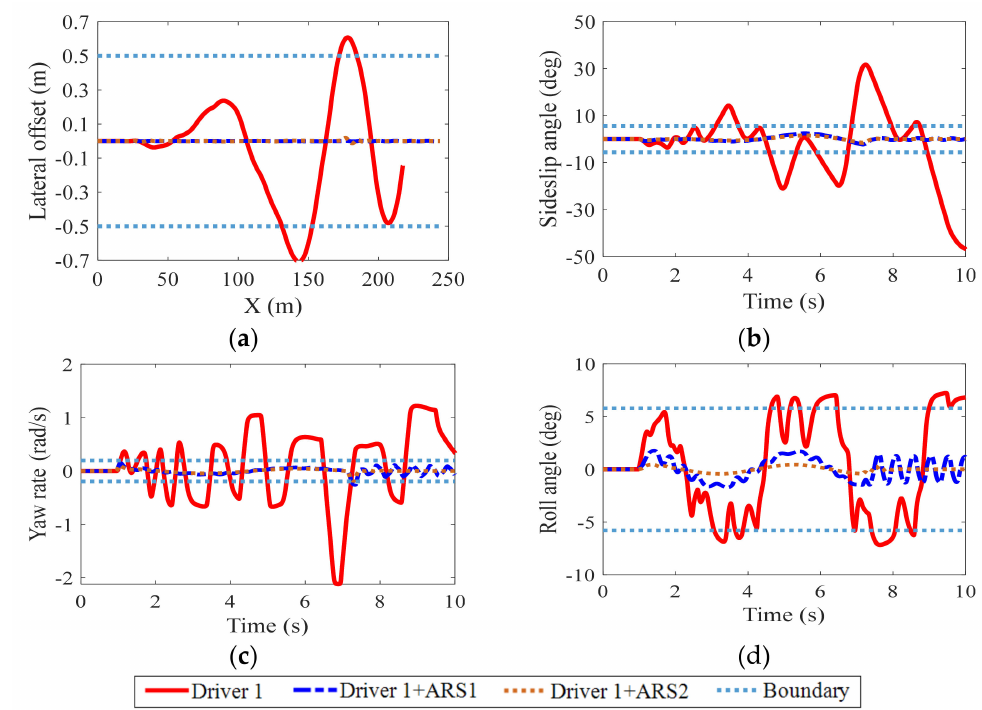
Figure 10. Active safety performances of vehicles in Case B: ( a ) lateral offset; ( b ) sideslip angle; ( c ) yaw rate: ( d ) roll